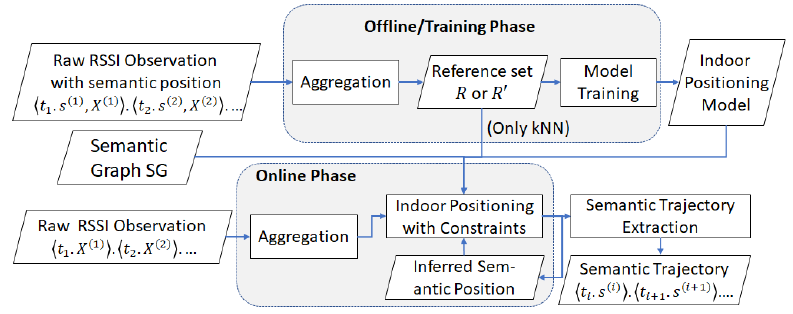
Figure 5. System architecture of our